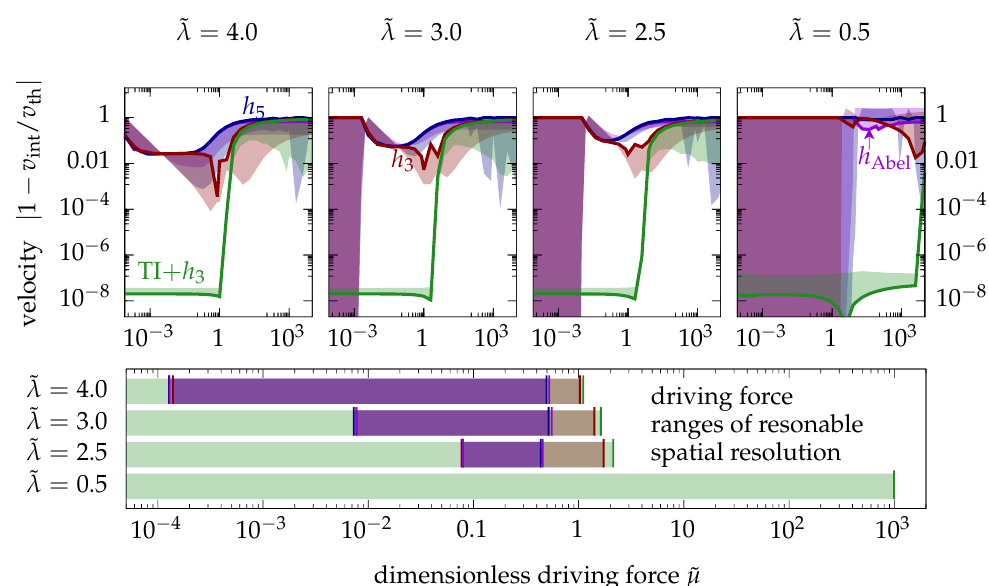
Figure 7. Logarithmic errors of the stationary interface velocity as a function of the dimensionless driving force ˜ µ = µ ∆ x / Γ for different profile resolutions: ˜ λ = λ / ∆ x = 4.0, 3.0, 2.5, 0.5. The behavior of different models is compared: (i) continuum field (CF) model with h Abel (violet), (ii) CF model with h 5 (blue), (iii) CF model with h 3 (red) and (iv) the sharp phase-field model with Translational invariance (TI + h 3 ) (green). Solid lines denote the mean relative errors and the oscillations are indicated as transparently colored areas (see Figure 1). The bottom plot compares the parameter windows of reasonable spatial resolution evaluated for the different models. Here, a model is reasonably resolved if the mean velocity error is lower than